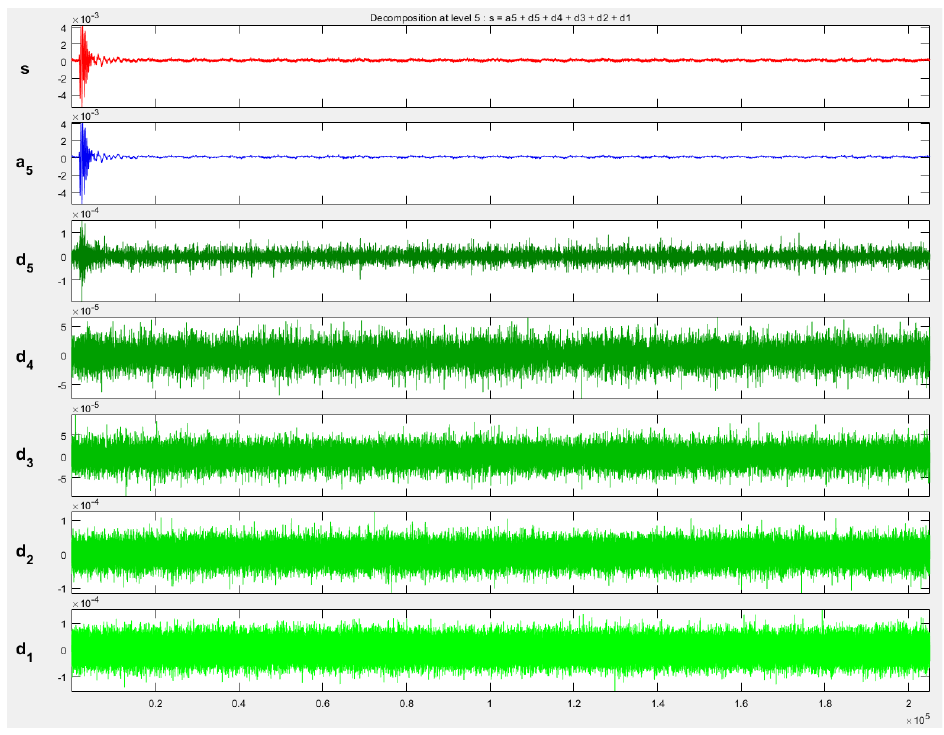
Figure 29. Waveform decomposition diagram of noise S2.